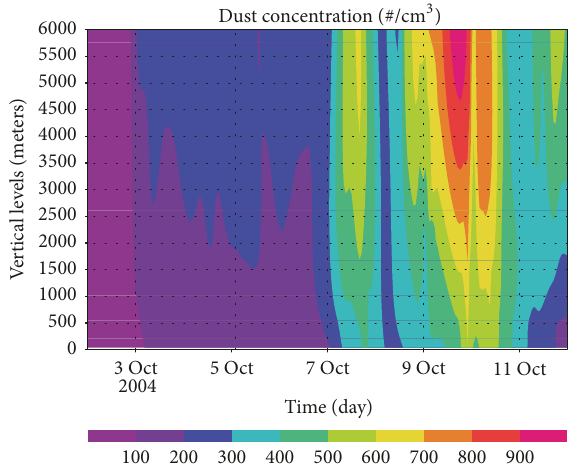
Figure 12: Daily average dust concentration profile for a1d10 for Case Study